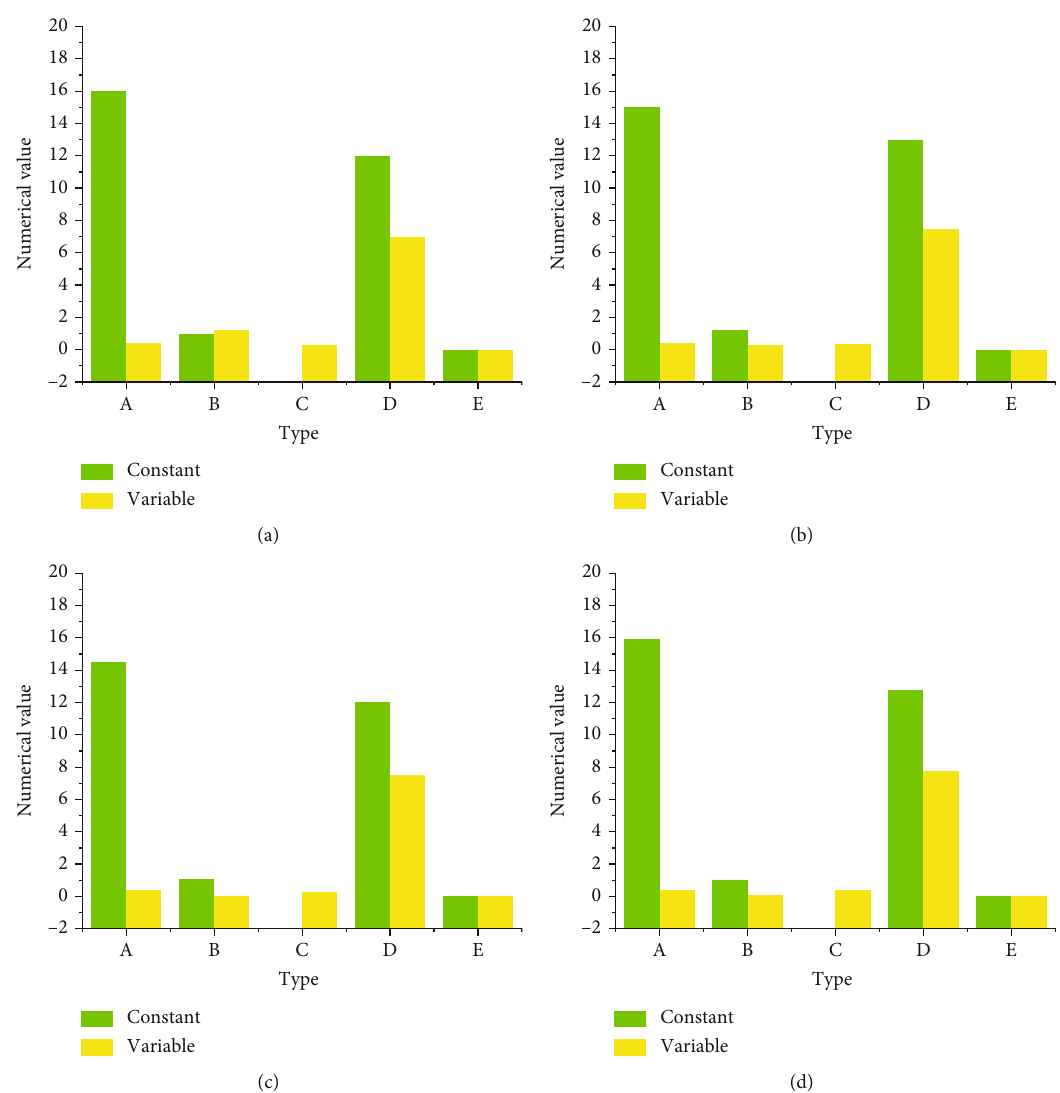
Figure 10: Statistics of the regression coe ffi cient of the employees ’ emotional contagion to leader narcissistic organizational identi fi cation ((a) pretending expression, (b) indi ff erent expression, (c) contempt expression, and (d) sincere expression. A: B value in nonstandardized coe ffi cient; B: standard error in nonstandardized coe ffi cients; C: standardization coe ffi cient; D: t value; and E: